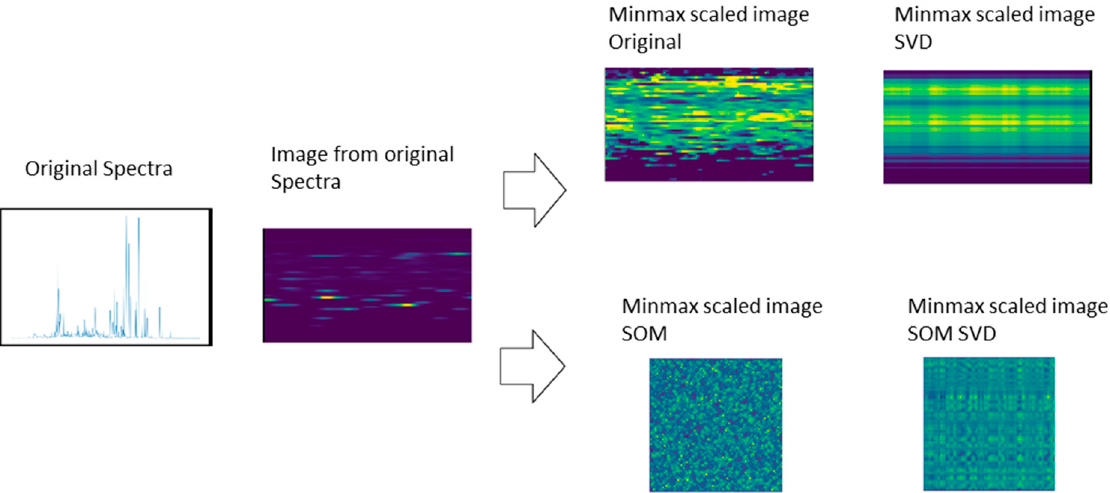
Figure 9. Each spectral datum was converted into four images; a min-max-scaled 2-dimensional array and its SVD reconstruction of first layer and a SOM-generated 2-dimensional array and its SVD reconstruction of the first layer. The arrows represent the routes to the methods of conversion (original and SOM).